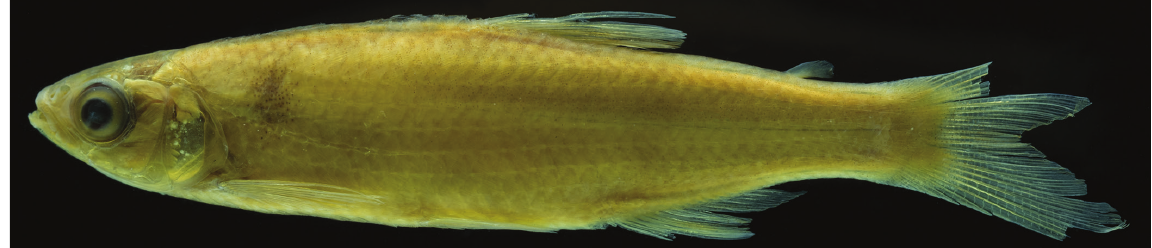
Figure 5. Holotype of Aphyocharax avary : ANSP 39217, 41.7 mm SL. Photographed by Axel Katz. Table 2. Meristic data of Aphyocharax